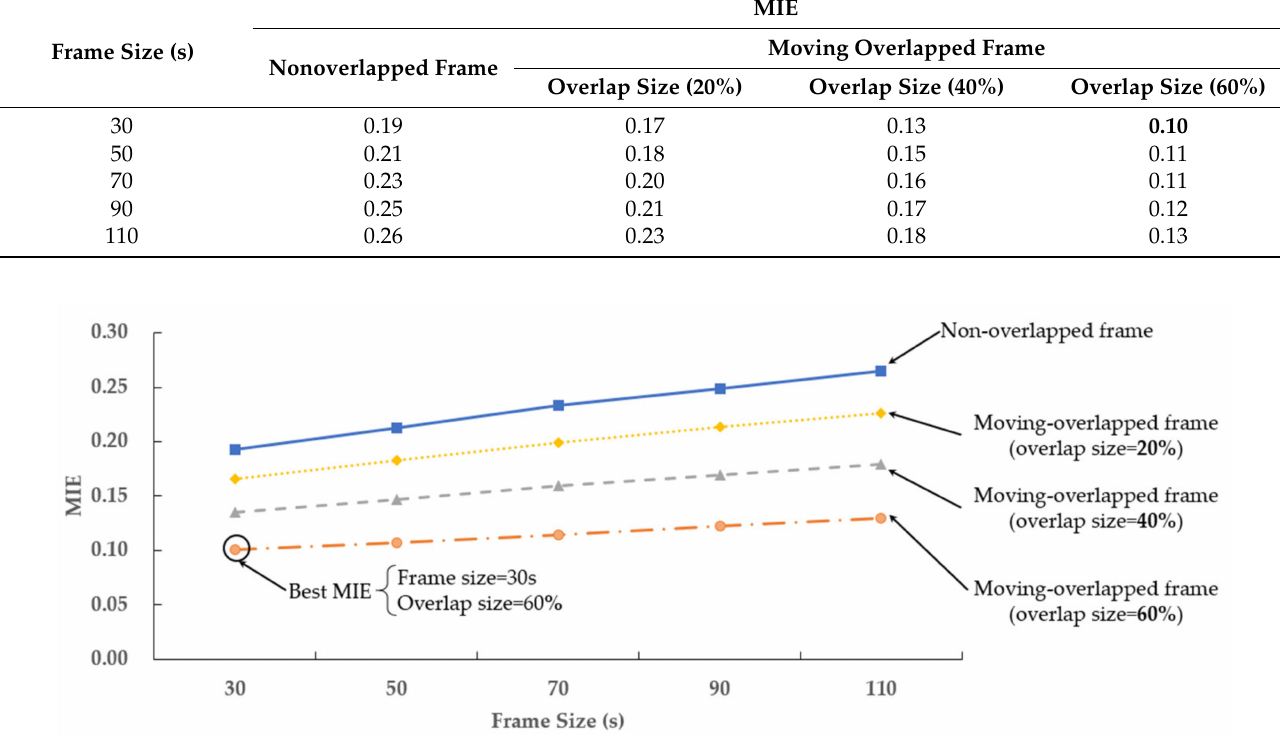
Figure 8. MIE of different framing